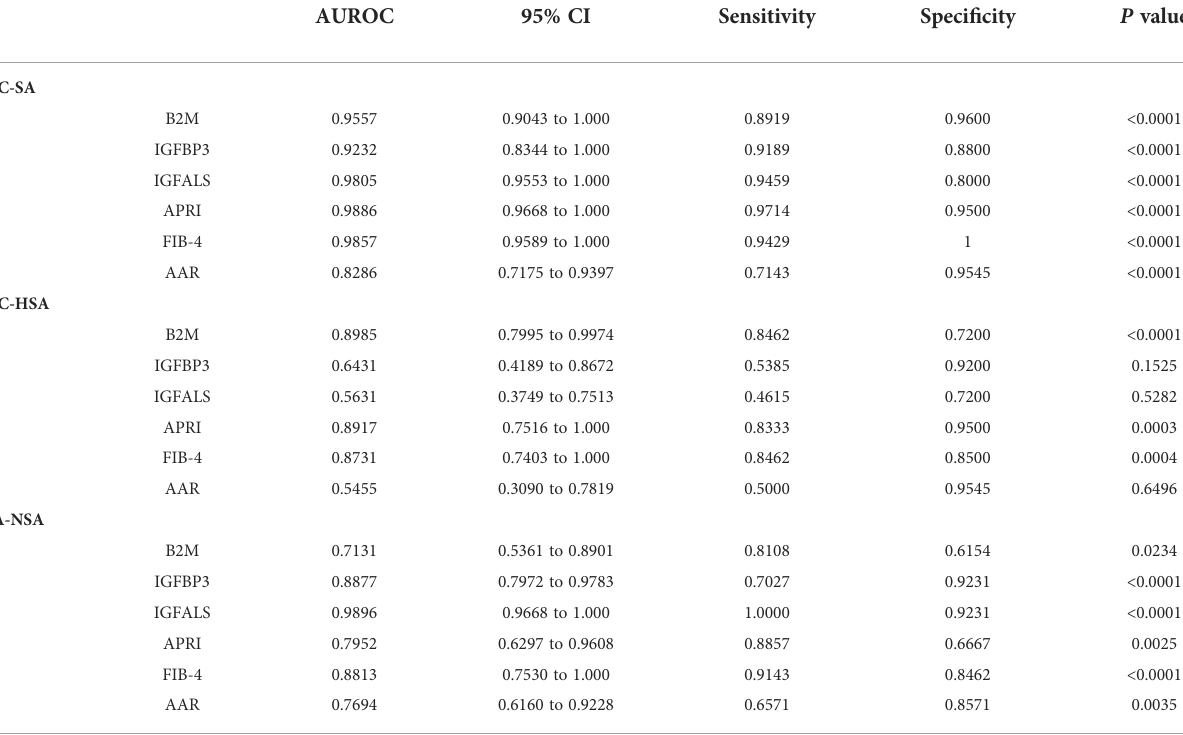
TABLE 5 Characteristics of potential proteins ROC curves.